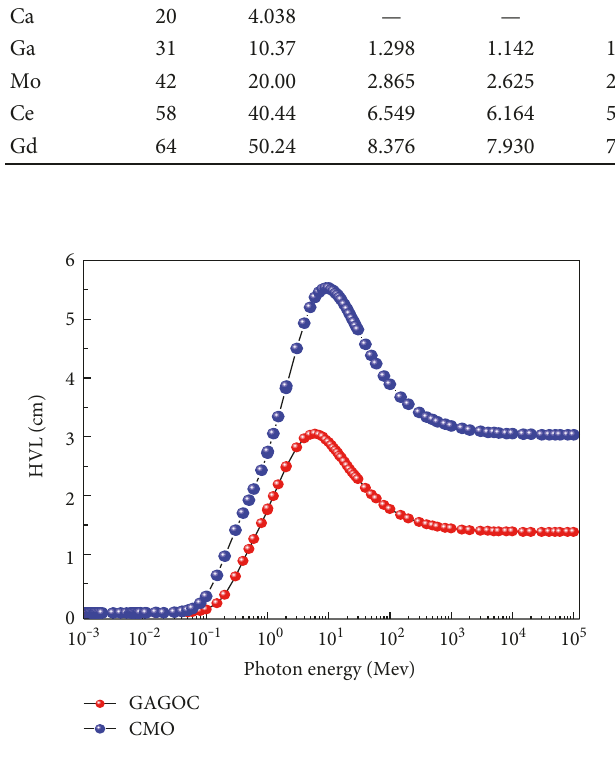
Figure 3: Variation of HVL versus incident photon energy for GAGOC and CMO.